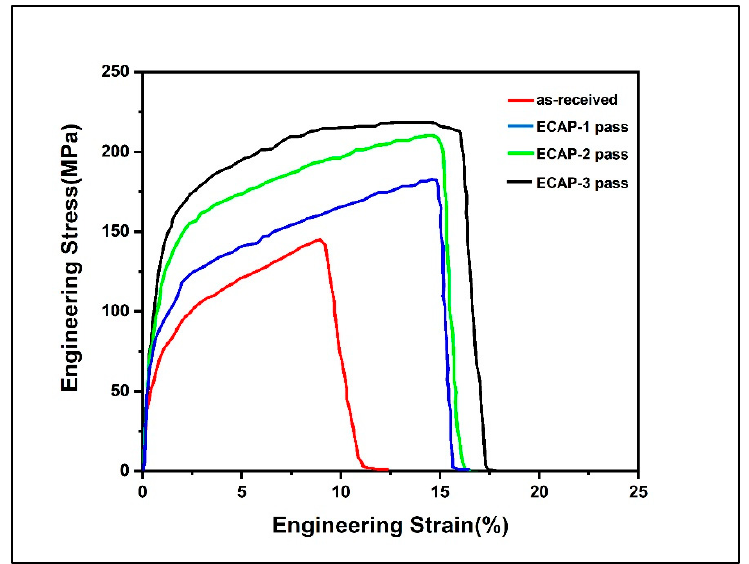
Figure 4. Stress–strain diagram of as-received Al5083 alloy ( A ) and ECAP after the 1st pass ( B ), 2nd pass ( C ), and 3rd pass ( D ) in air and 3.5% NaCl solution.